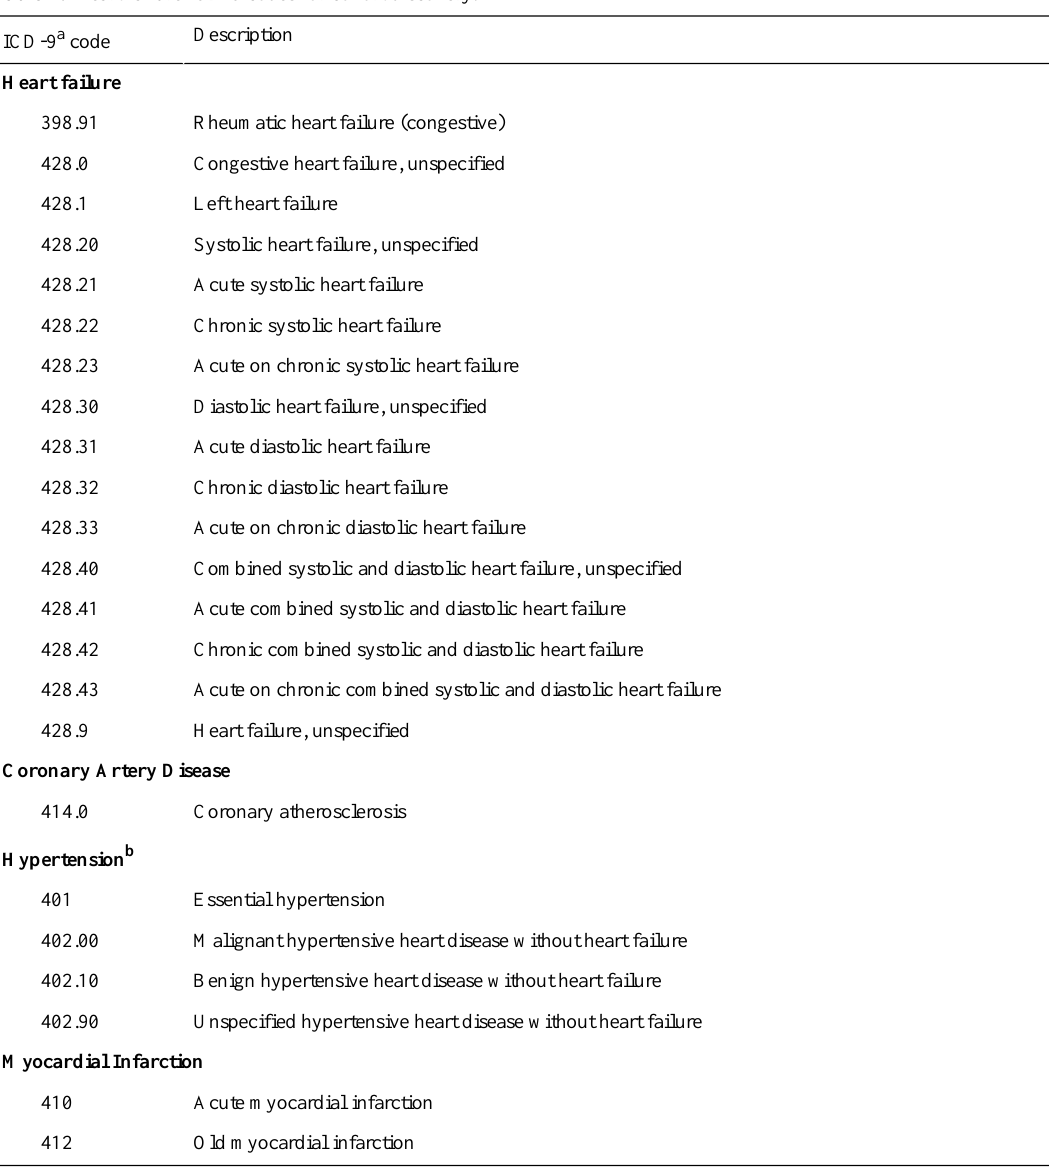
Table 1. Heart failure ICD-9 codes for cohort